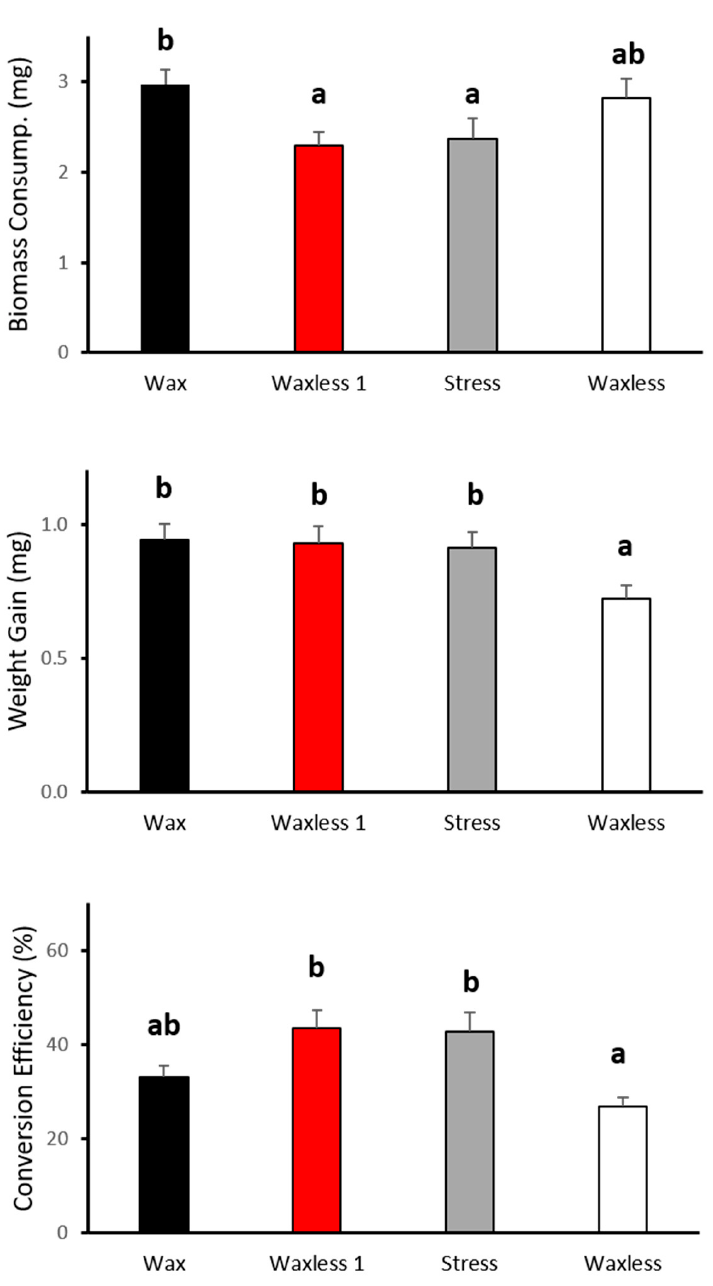
Figure 2. Larval feeding parameters (mean ± SE) from Wax, Waxless once (Waxless 1), Stress and Waxless larvae of S. nubilus. Different letters indicate significant differences ( p < 0.05).